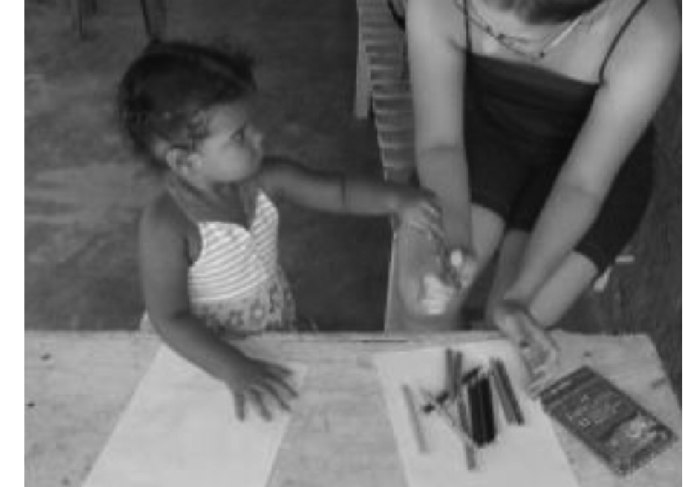
Figura 3. Momento em que a criança tem acesso ao lápis que estava na mão da pesquisadora e fala “dá